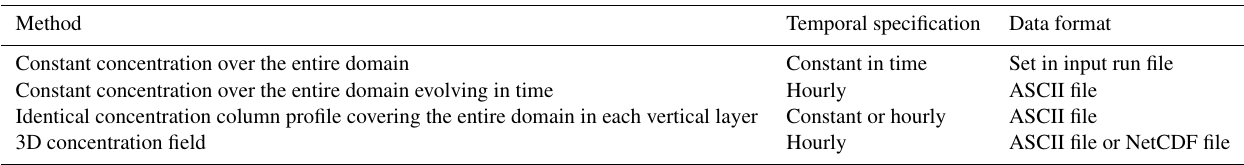
Table 2. A list and description of all of the possible methods to include initial and background pollutant concentrations in EPISODE model